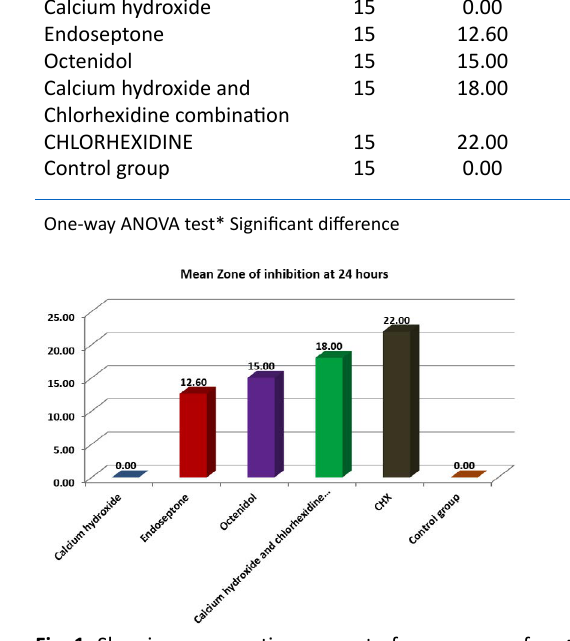
Fig. 2. Showing zone of inhibition at 72